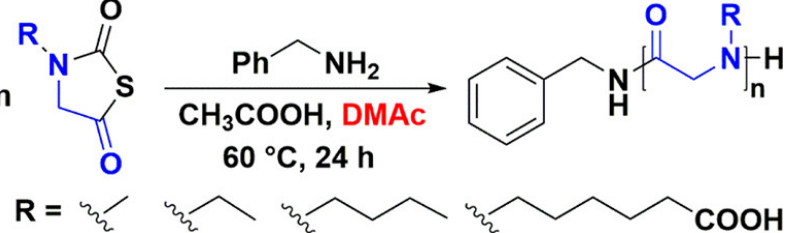
Figure 18. Activated polymerization of NNTAs in polar solvents (Adapted from ref. [98]. Copyright 2021, American Chemical Society).